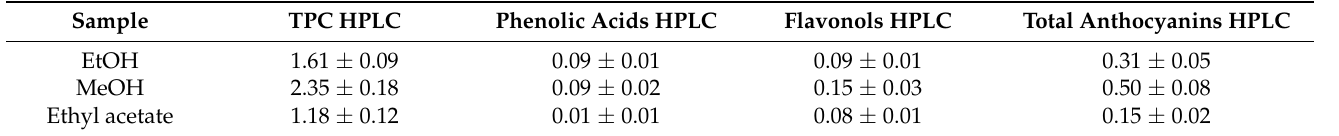
Table 1. Total polyphenol content of each extract. EtOH: 80–20% EtOH-water acidified with 5% acetic acid (S1); MeOH: 80–20% MeOH-water acidified with 5% acetic acid (S2); ethyl acetate acid-